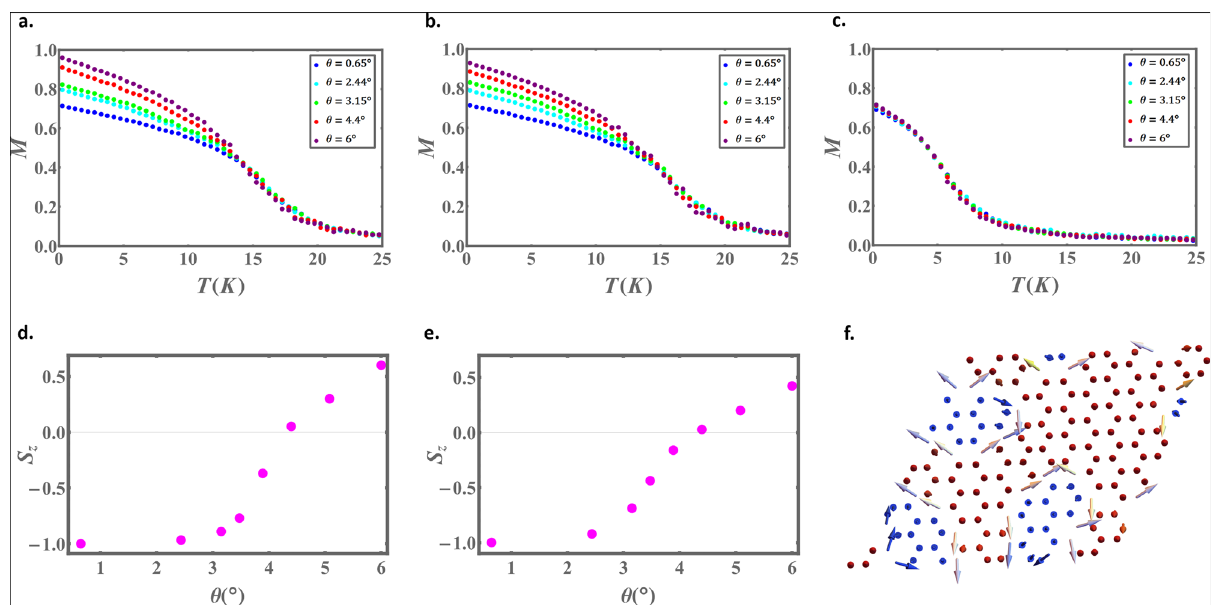
Fig. 5 Twist angle effect on the ground state averaged magnetization ( M ). a – c The M (cid:3) T curves ( T represents temperature) for selected twist angles in the nonchiral Heisenberg ( a ), Heisenberg-IDMI ( b ), and Heisenberg – Kitaev ( c ) models. IDMI stands for the intrinsic Dzyaloshinskii – Moriya interaction. The twisted bilayers are polarized by a magnetic fi eld B ¼ 1 ^ z T . In ( a ) and ( b ), the averaged magnetization approaches the pure FM ground state in the large twist angle interval θ ≳ 4 : 3 (cid:2) . However, in ( c ), the averaged magnetization is almost independent of the twist angle. d , e The minimal S z ( z component of the spin) value in the moiré supercell as a function of the twist angle for the Heisenberg ( d ) and the Heisenberg-IDMI ( e ) models at T ¼ 0 K . A steep increase in S z is observed in the interval θ ≳ 3 (cid:2) . At θ ≳ 4 : 3 (cid:2) , the magnetic bubbles (MBs) disappear in both models. f Persistent ground state MBs in the top layer of the nonchiral Heisenberg – Kitaev model at θ ¼ 6 (cid:2)